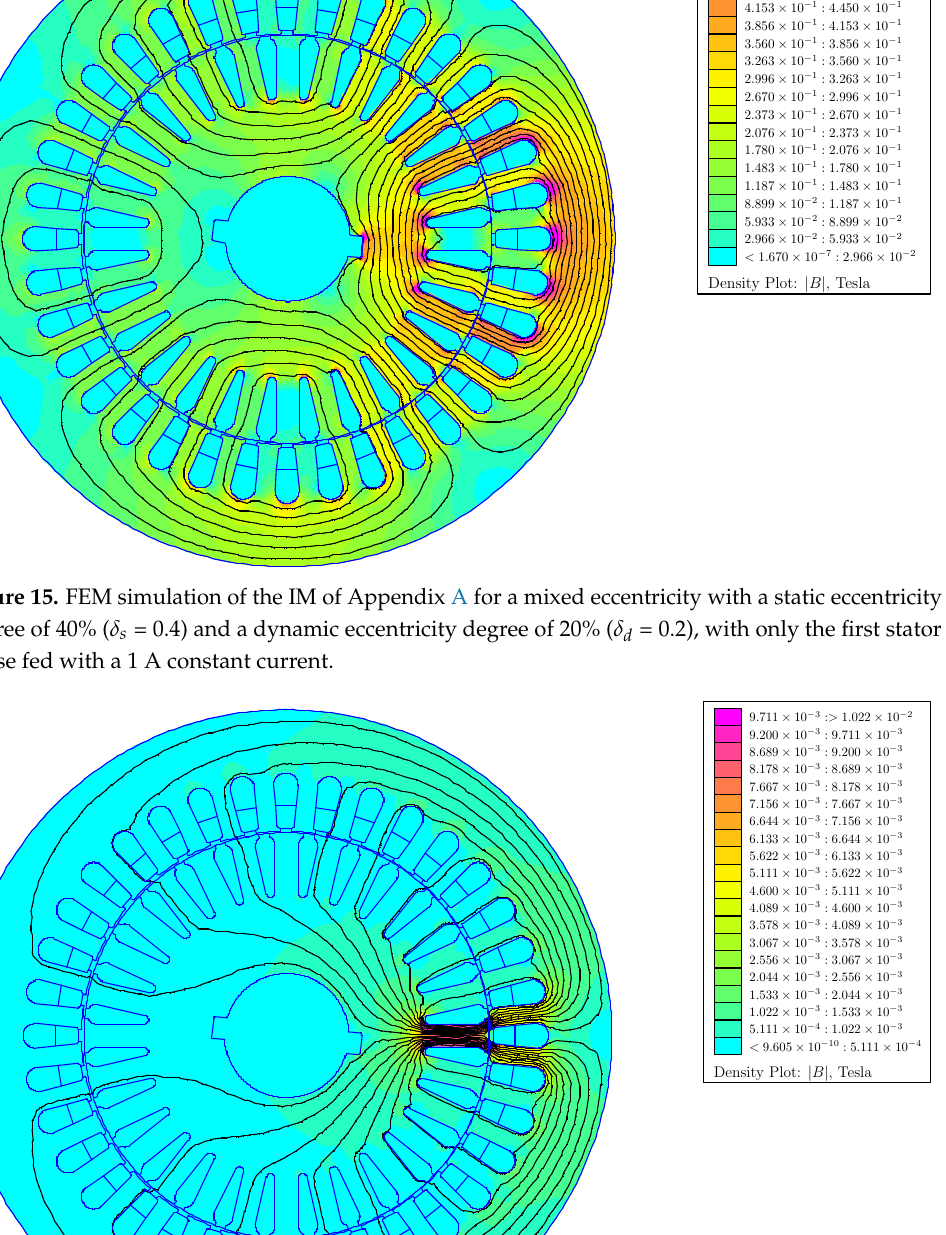
eccentricity with a static eccentricity degree of 40% ( δ s = 0.4) and a dynamic eccentricity degree of 20% ( δ d = 0.2).